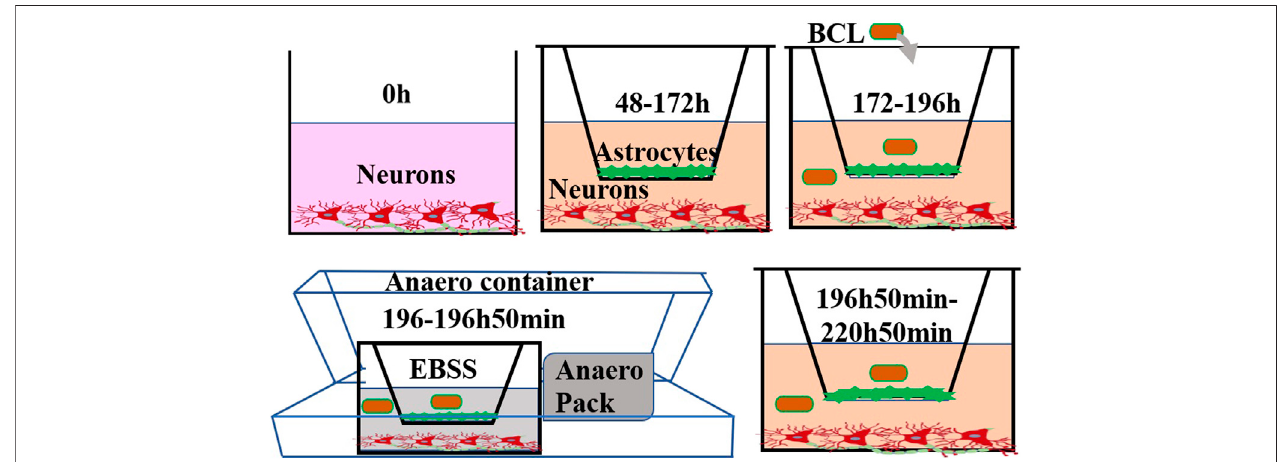
FIGURE1| Experimentalstepsofthisstudy.NeuronswereculturedatthebottomofaTranswell fi lterat0h.After48h,astrocyteswereseededontheuppersideof the inserts. At 172 h, the experiments were performed. The cells were treated with BCL for 24 h prior to OGD/R. To mimic ischaemic conditions, cocultures were subjectedtoOGD for50min, andthe cultureswere returned toanormoxicincubator for24h.Structuraland functionalevaluations under pathophysiologicalconditions were undertaken at 220 h 50 min.